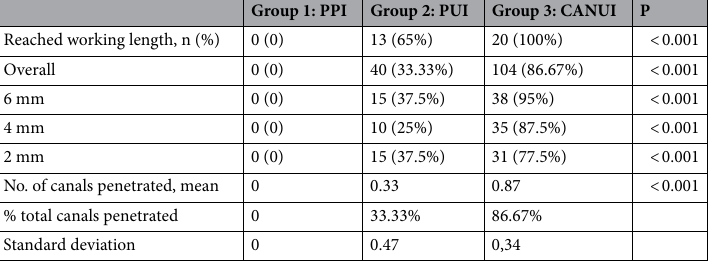
Group 1: PPI Group 2: PUI Group 3: CANUI